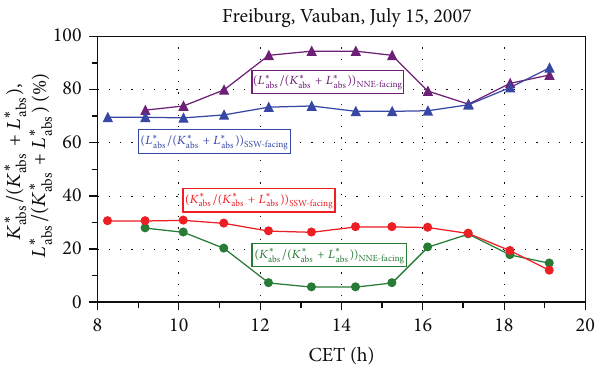
Figure 14: 1h mean values of the sums of short-wave radiant ) and long-wave radiant flux densities ( 𝐿 ∗ flux densities ( 𝐾 ∗ abs from the three-dimensional environment absorbed by the human- biometeorological reference person, related to 1h mean values of + 𝐿 ∗ ), at the shaded NNE- and sunny SSW-facing sidewalk ( 𝐾 ∗ abs abs of a WNW-ESE street canyon, “Vauban” quarter in Freiburg during typical Central European summer